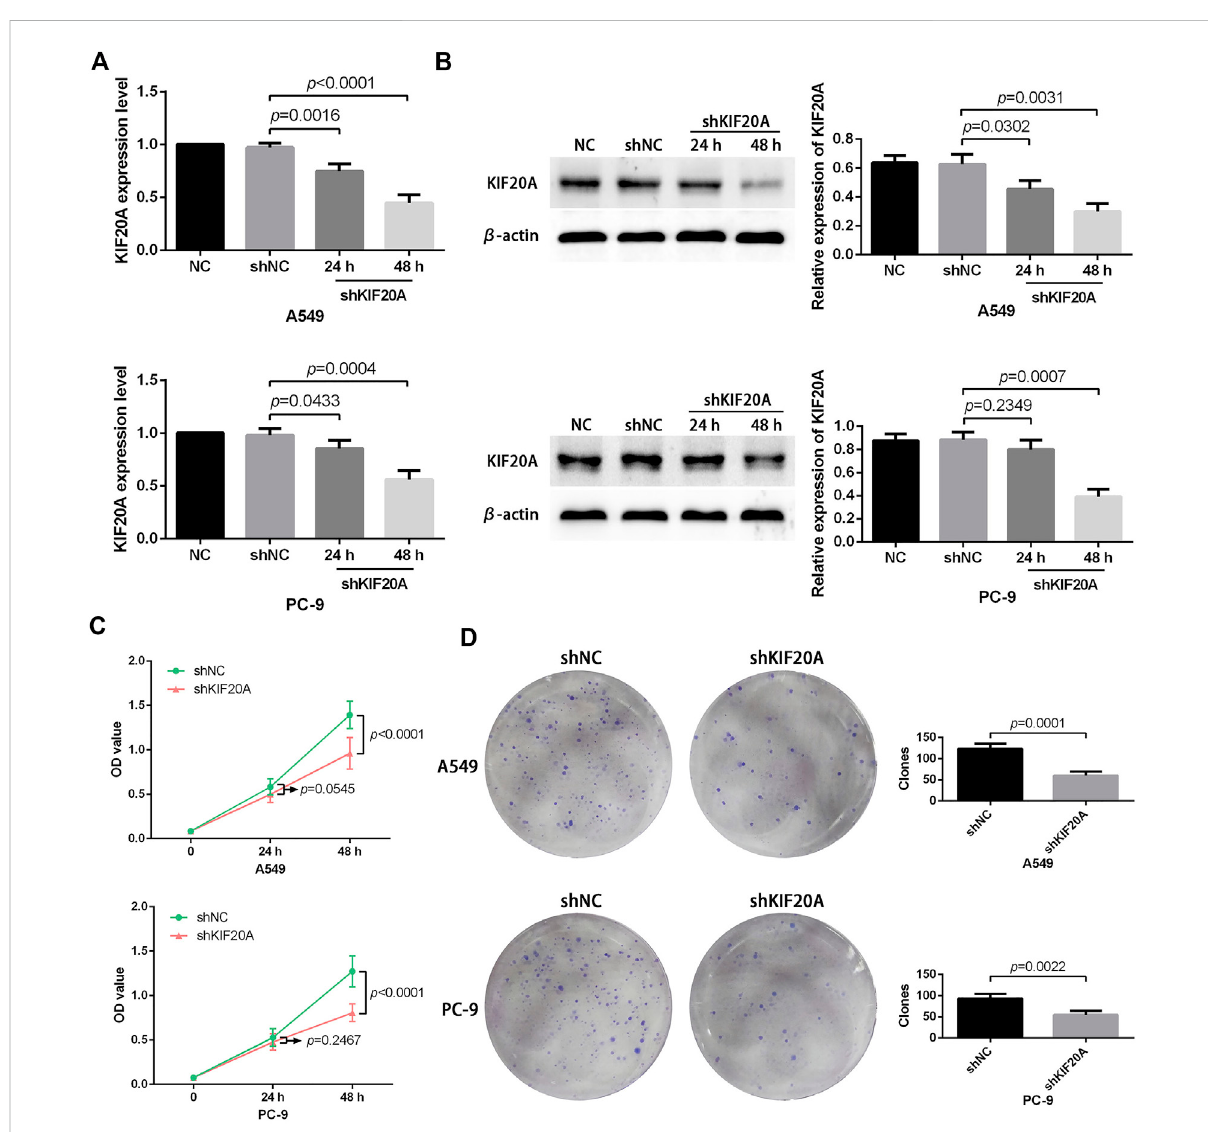
FIGURE 10 Effects of KIF20A knockdown on the proliferation of A549 and PC-9 cells. Ef fi cacy of KIF20A deletion measured by qRT-PCR (A) and Western blot analysis (B) . KIF20A deletion inhibited cell growth in the CCK-8 test (C) and colony formation assay (D)